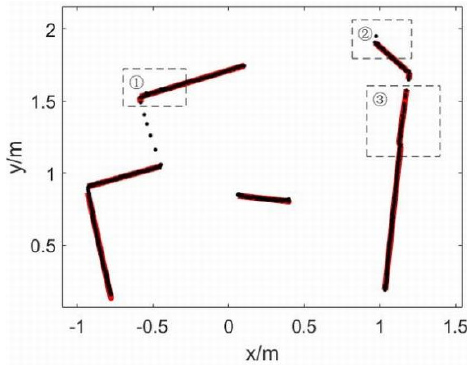
Figure 9. Line fitting graph of this algorithm.